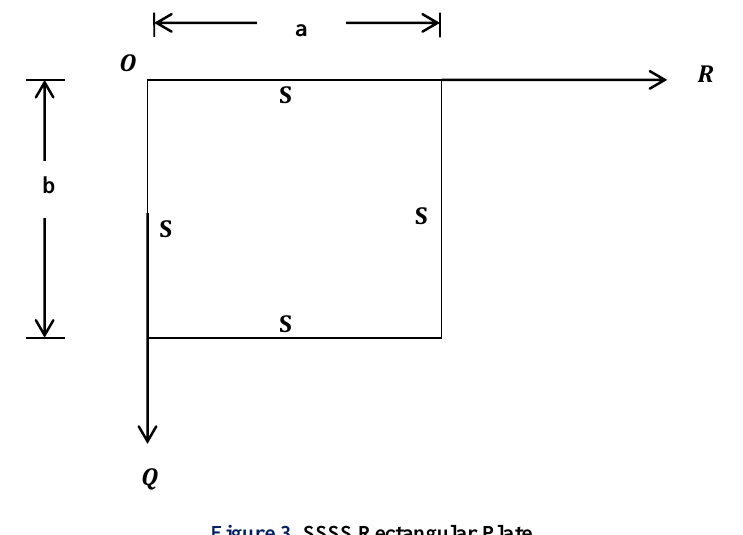
Figure 3. SSSS Rectangular Plate.